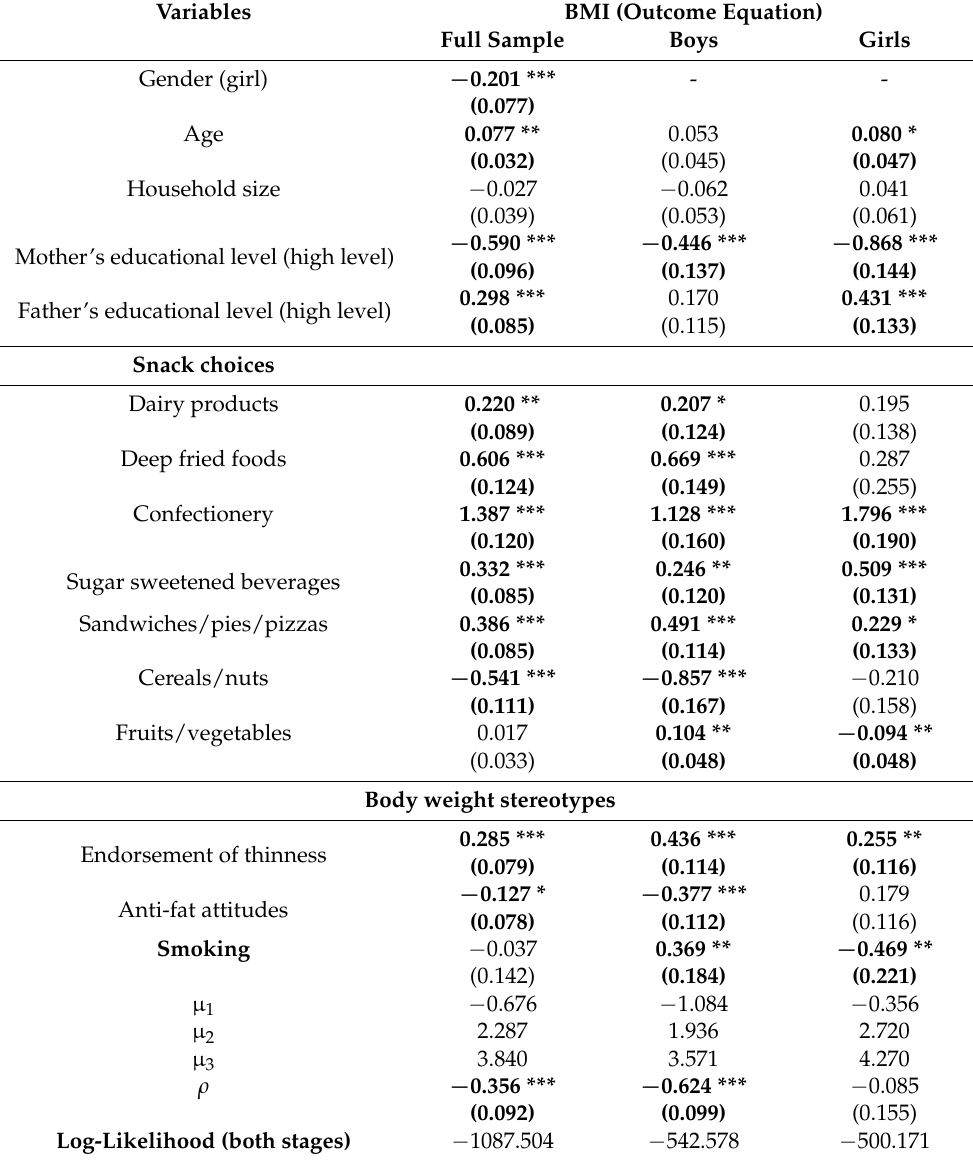
Table 5. Adolescents’ BMI estimates of the endogenous treatment effects model—Outcome